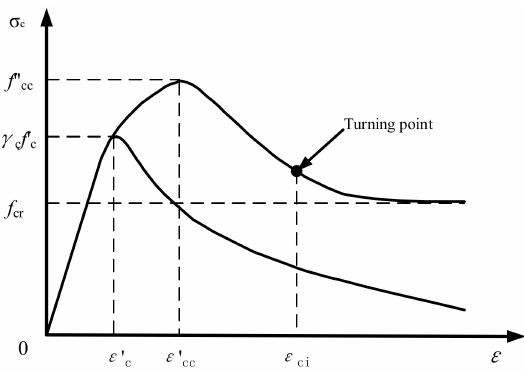
Figure 4. Stress–strain curves of confined